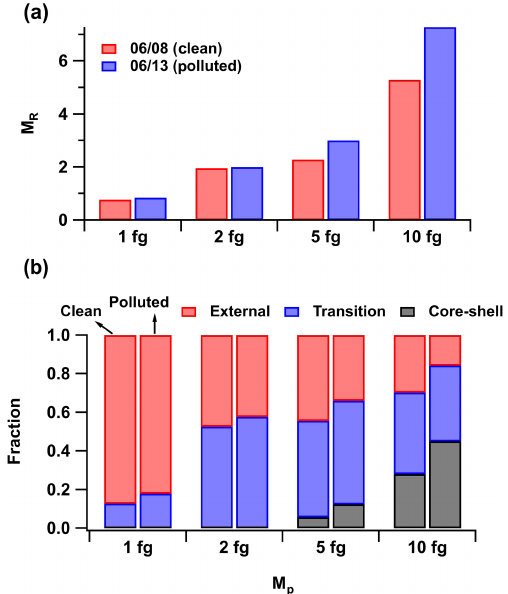
Figure 11. (a) The average M R (the mass ratio of nonrefractory matter to rBC) under different CPMA set points (1, 2, 5, 10fg). (b) The fraction of different types of rBC-containing particles under different CPMA set points under varied pollution